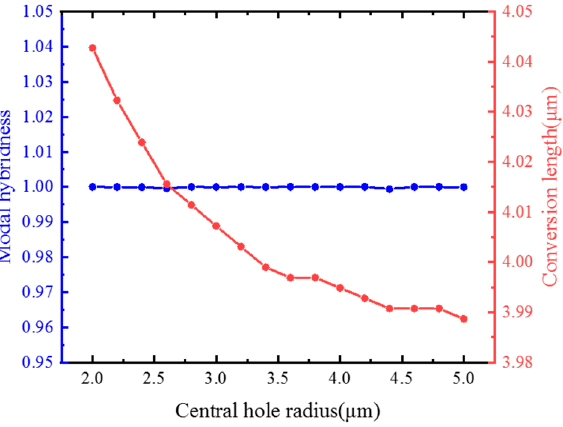
Figure 8. Dependences of the modal hybridness and conversion length for different values of the central hole radius r.